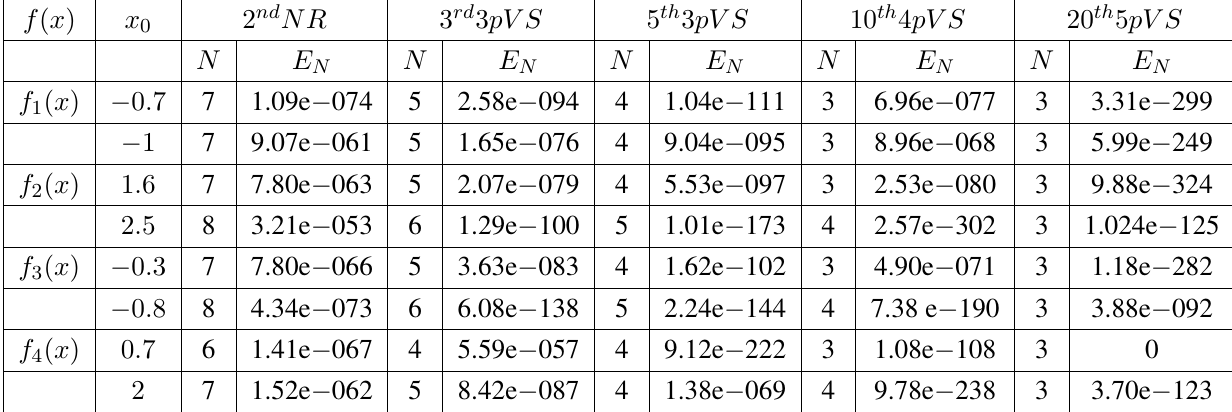
Table 1. Results for the 5 th 3pVS , 10 th 4pVS and 20 th 5pVS Iterative Functions (I.F.s)